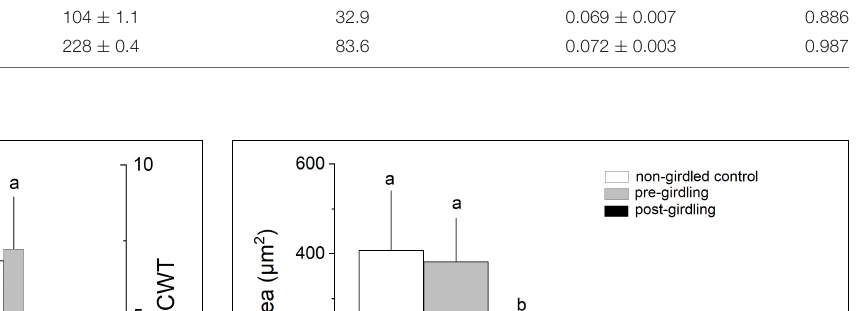
TABLE 3 | Parameters of the Gompertz function for radial growth dynamics of trees during the regular (i.e., pre-girdling) and induced (i.e., post-girdling) growing period (cf. Figure 2 ) and R 2 of the model ( A , upper asymptote; I p , inflection point; κ , rate of change parameter; and Growth max , maximum daily growth at inflection point). Growing period